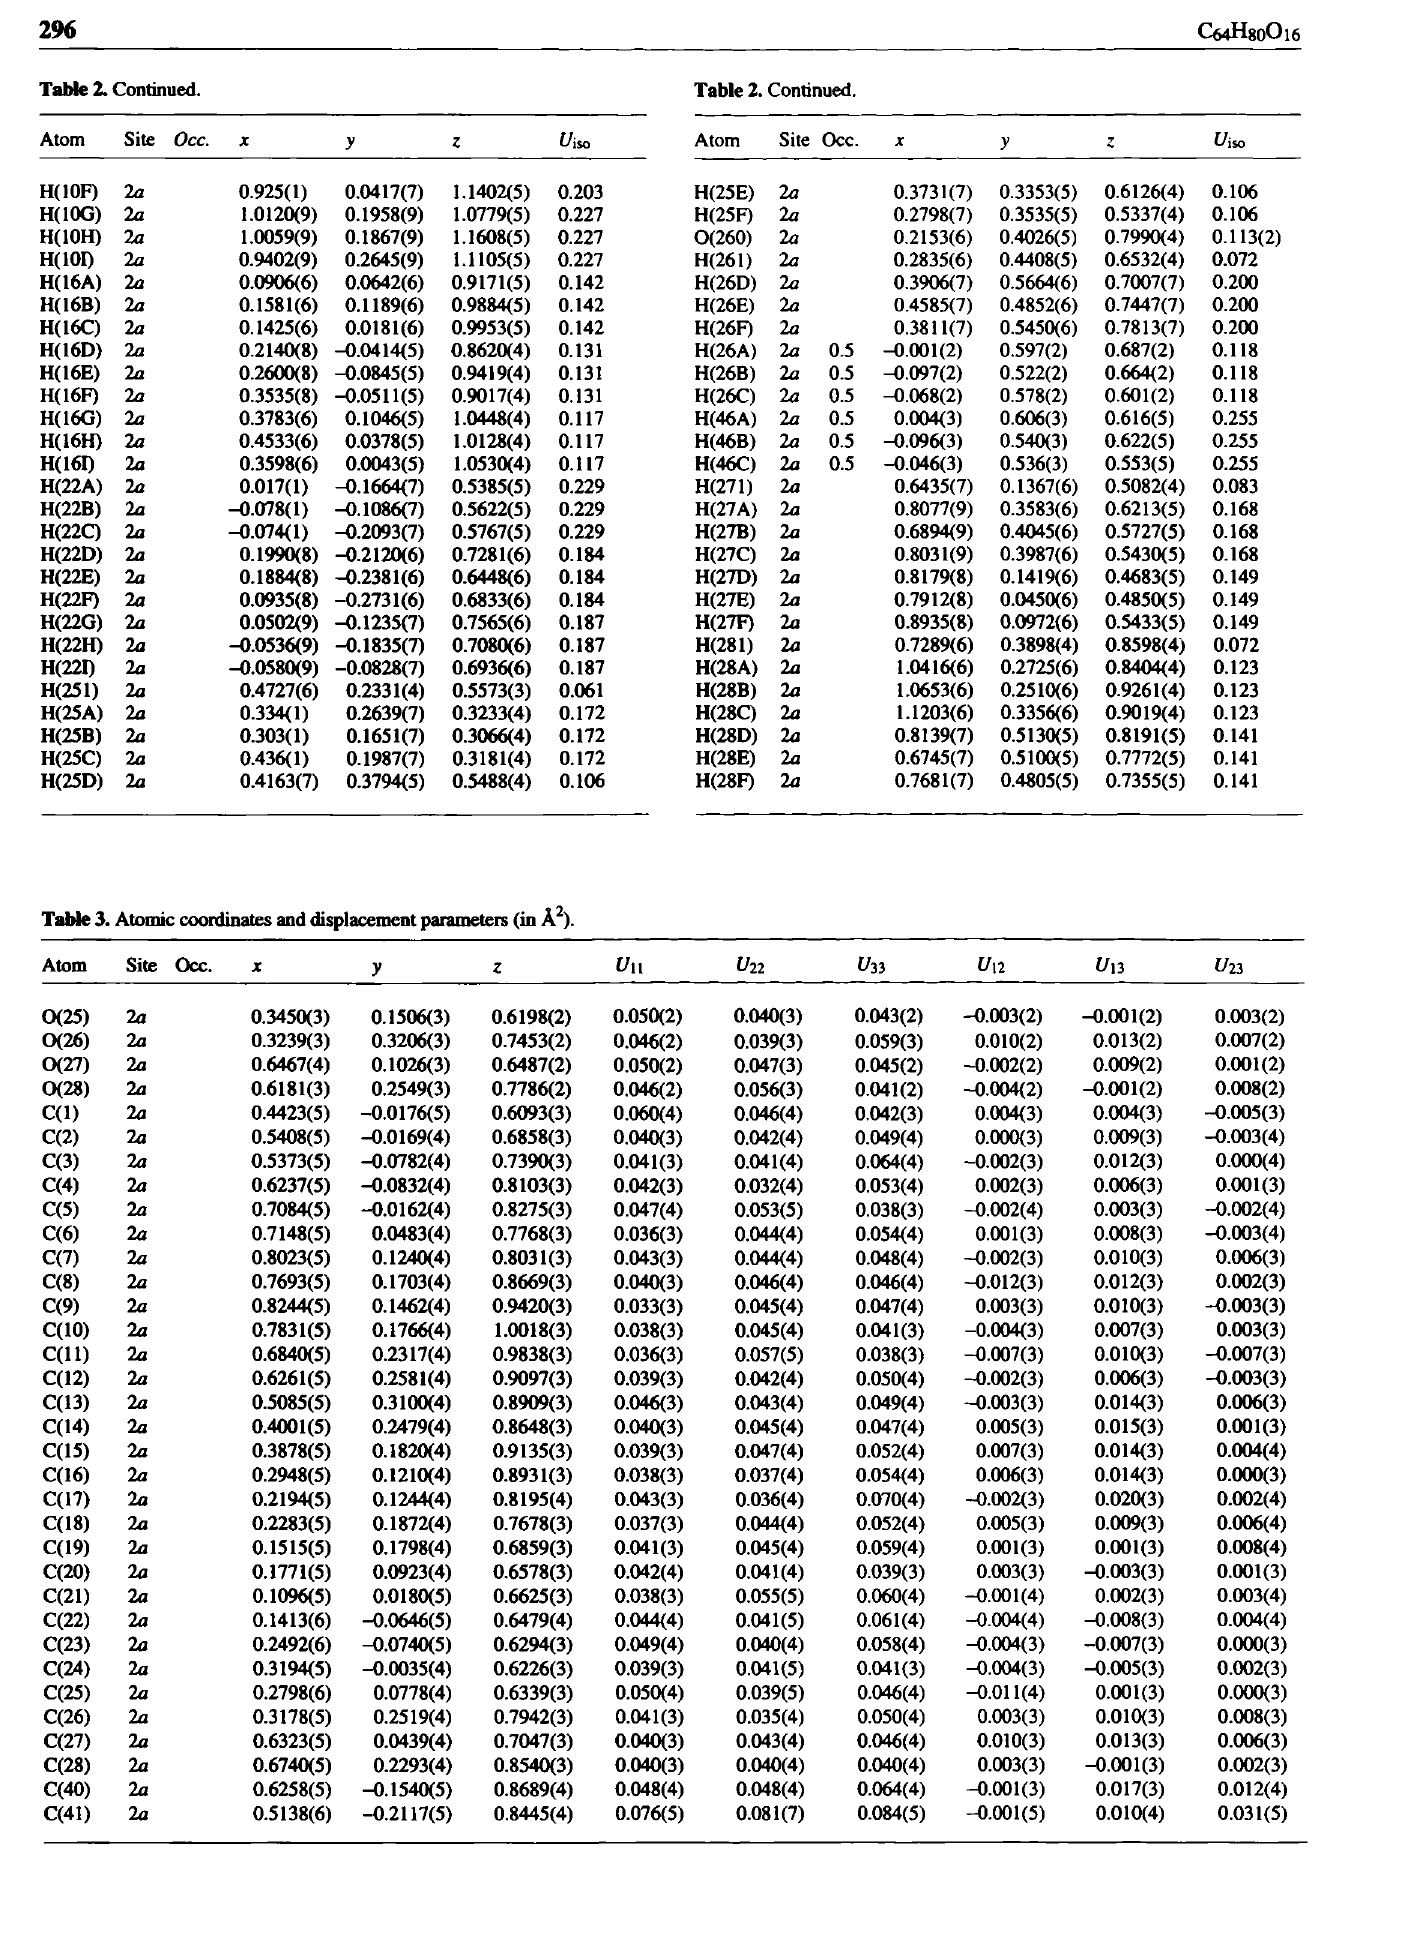
Table 3. Atomic coordinates and displacement parameters (in Â 2